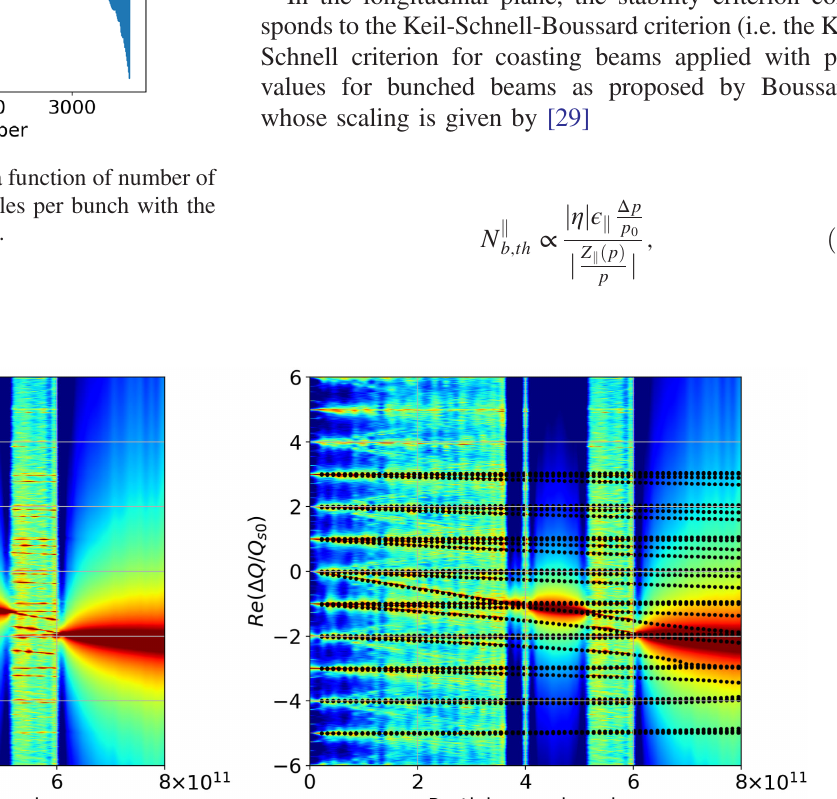
FIG. 15. Comparison of the real part of the normalized mode-frequency shift between P y HEADTAIL and GALACTIC (black dots in the right-hand side) with the transverse BBR